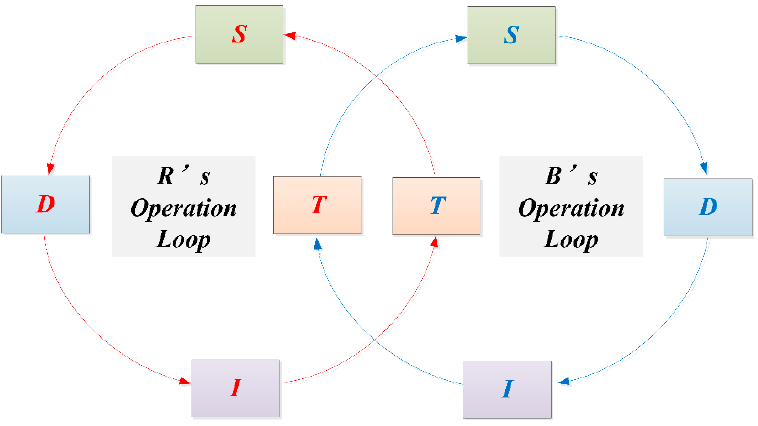
Figure 3. Schematic of an operation loop in battle.